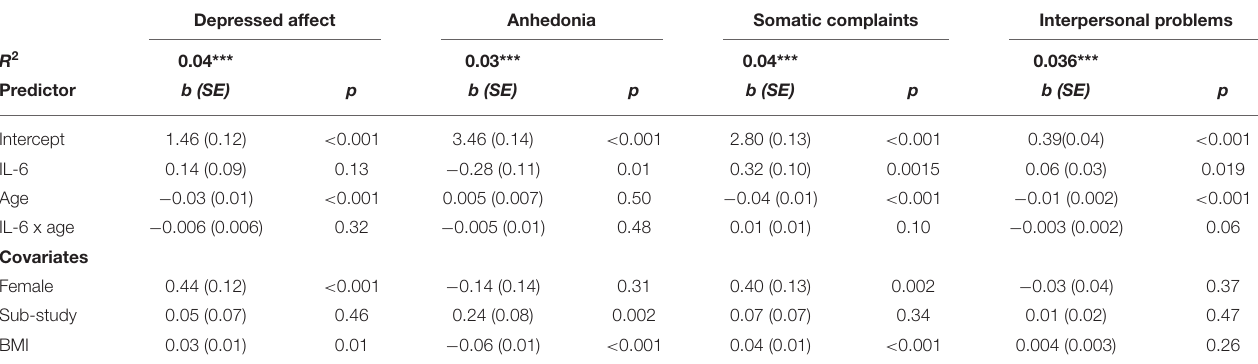
TABLE 4 | Estimated coefficients predicting depressive symptoms and phenotypes from IL-6, age, and their interaction. Depressed affect Anhedonia Somatic complaints Interpersonal